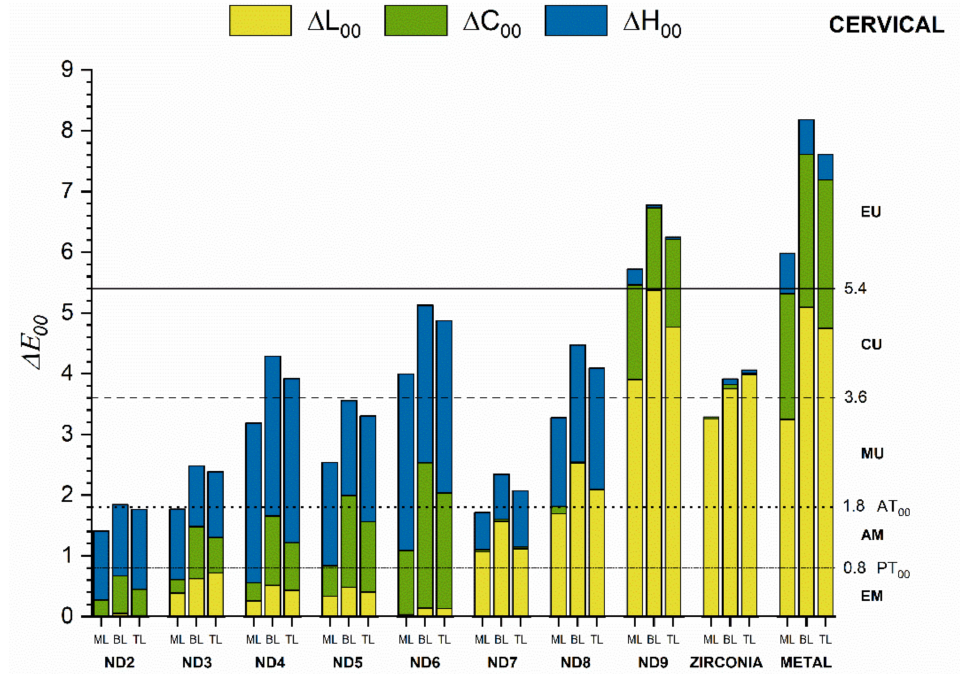
Figure 6. Masking ability of crown groups on different substrates evaluated for the cervical area.